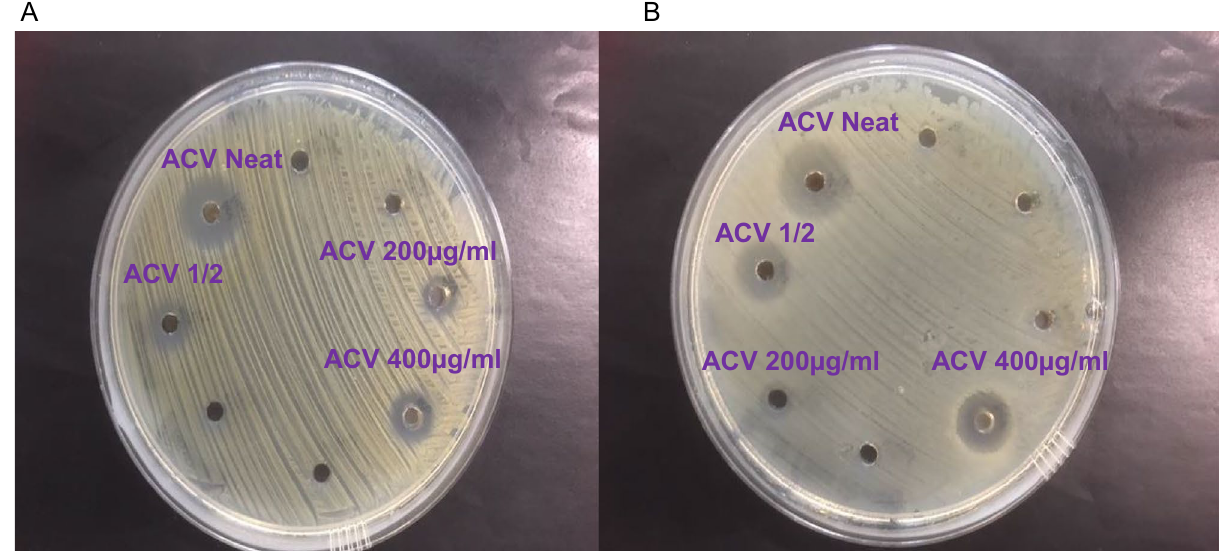
Figure 1. Effect of ACV on microbial growth after incubation at 37° C for 24 h on agar plates. ( A ) Resistant E. coli ; ( B ) MRSA. ACV was either applied neat, 1:2 v/v in distilled water or ACV tablets at 400 or 200 μg/ml. Photographs were taken using a 20 Mega pixel Samsung